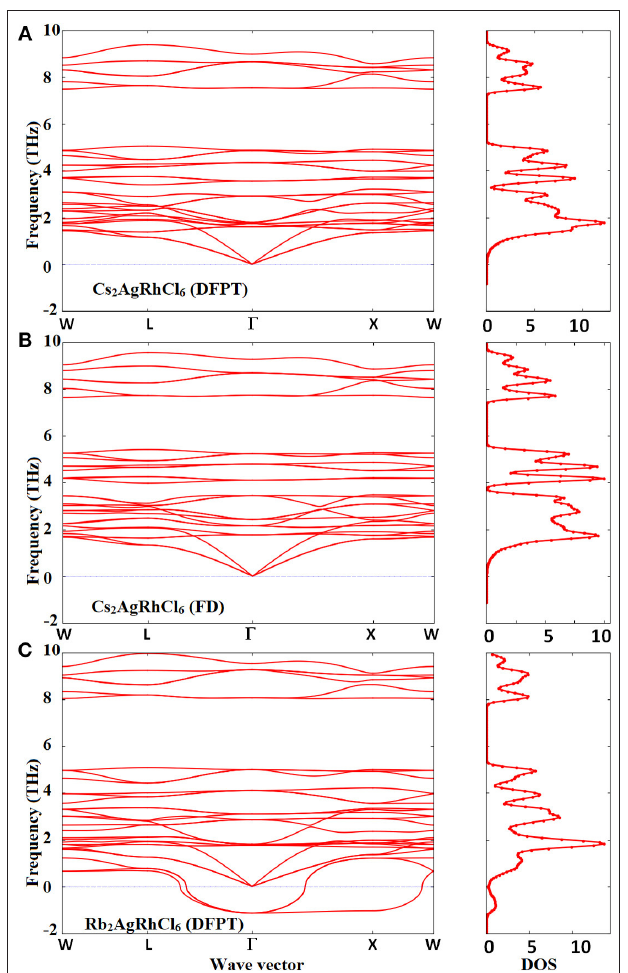
FIGURE 7 | Comparison of the phonon dispersion and total phonon density of states (a.u.) of Cs 2 AgRhCl 6 calculated using the (A) DFPT/PBEsol and (B) FD (finite difference) methods. Shown in (C) are the corresponding features for Rb 2 AgRhCl 6 , calculated using DFPT/PBEsol method with the supercell approach. Phonon “soft” modes are present around the Brillouin-zone boundary points and Γ X W for Rb 2 AgRhCl 6 → →